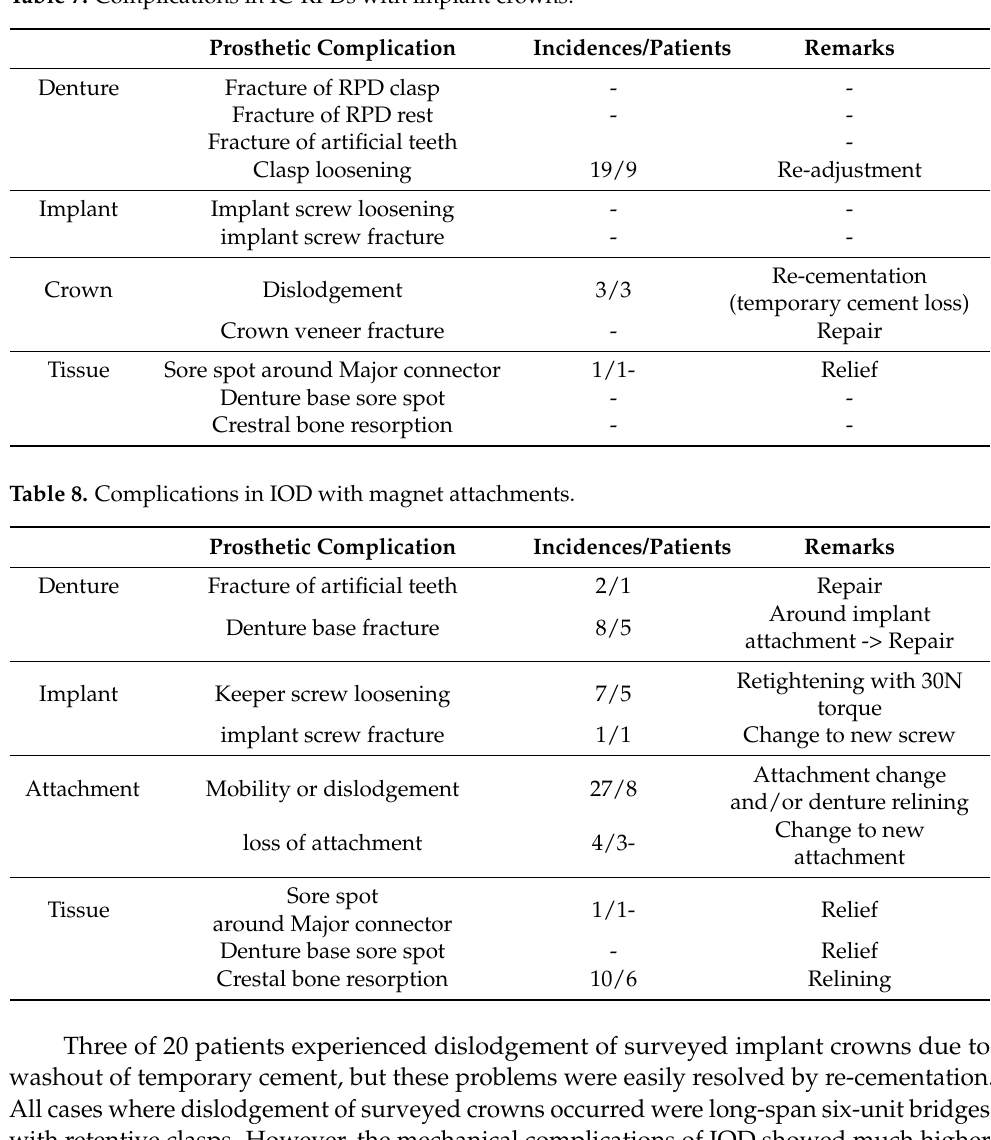
Table 7. Complications in IC-RPDs with implant crowns.